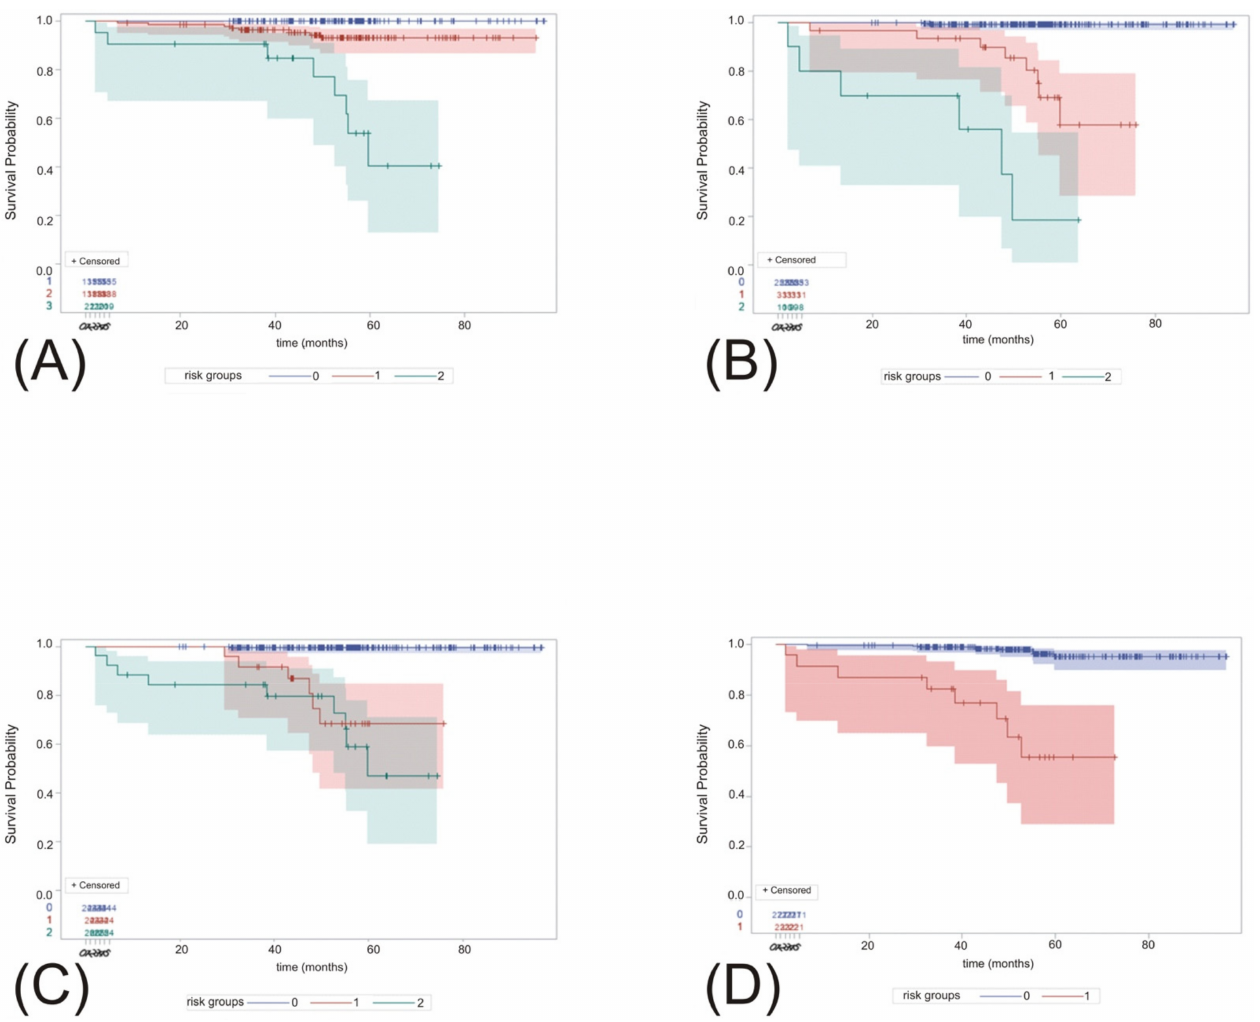
Figure 1. Kaplan–Meier curves representing cancer-specific survival according to the risk stratification as determined by our classification ( A ), and Leibovich ( B ), VENUSS ( C ) and GRANT ( D ) models. p -Values < 0.0001 were reached in all the respective models between the risk groups. Respective risk groups (0–2) were presented in different colors ( A – D